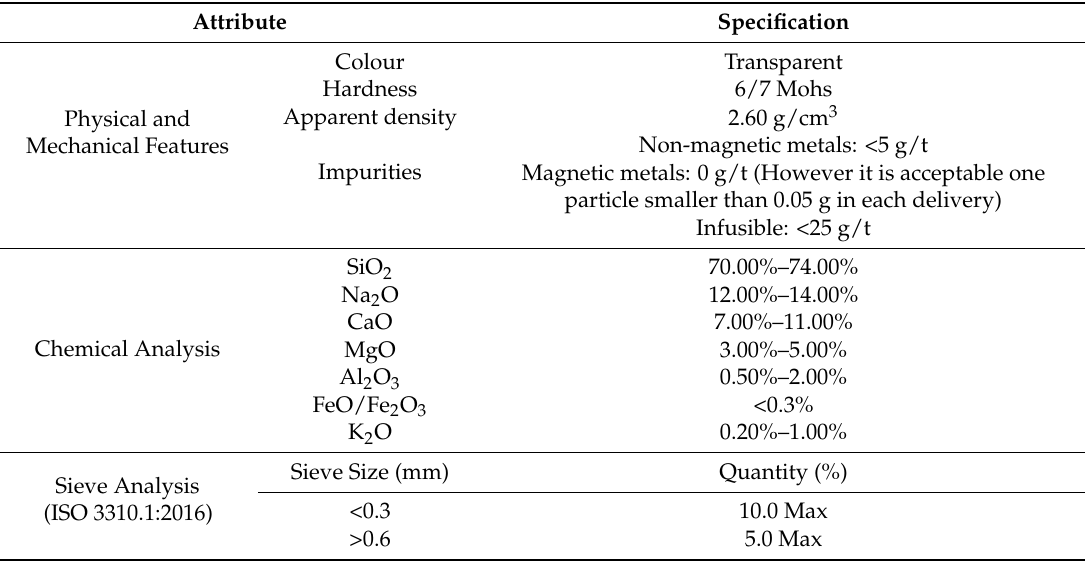
Table 10. Glass 600 granules specifications.